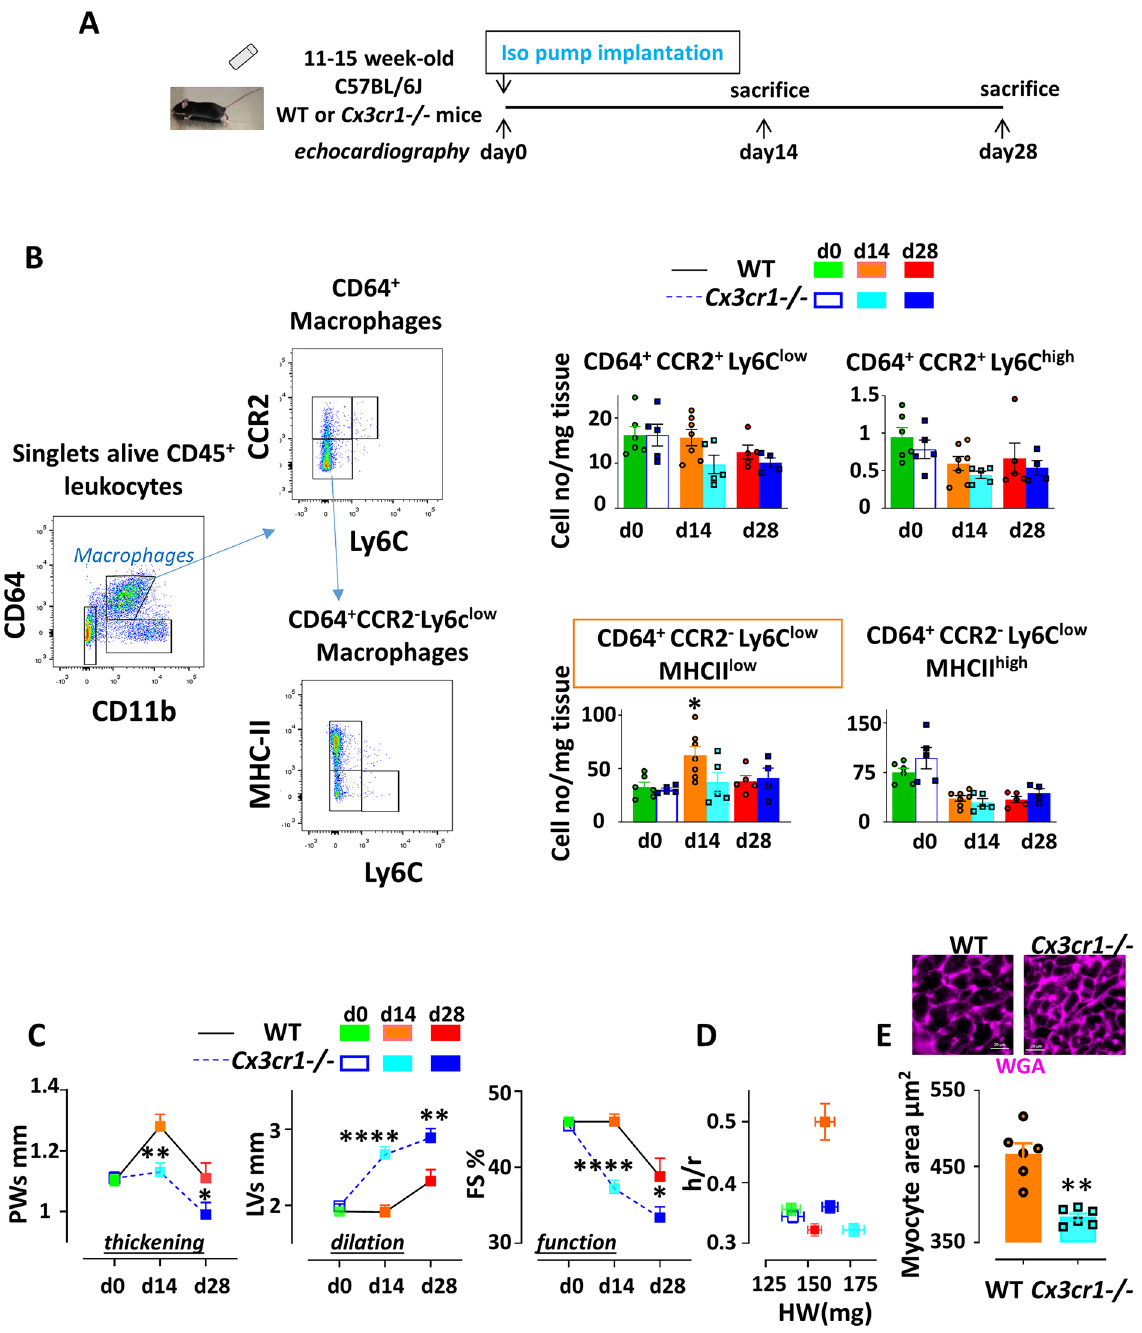
Figure 5. Cx3cr1 knockout hampers the transient selective increase in CD64 + CCR2 - Ly6C low MHCII low Mφ detected in WT mice during ECH, suppresses iso-induced concentric hypertrophy and accelerates dilation and alteration of function. ( A ) Experimental procedure ( B ) Typical flow cytometry gating strategy to identify cardiac Mφ subpopulations. Cells were isolated from collagenase digested hearts and stained with the indicated antibodies before analysis. CD45 + leukocytes were identified, doublets excluded (by FSC-W vs. SSCA). Live CD45 + cells (after PI exclusion) were gated on CD11b + CD64 + Mφ. CD11b + CD64 + Mφ were further analyzed on their pattern of expression of CCR2 vs Ly6C and CCR2 - Ly6C low cells were gated on MHCII high and MHCII low cells. Quantification of immune cells n = 4–7 cell isolation, two-way ANOVA followed by Sidak’s post-hoc tests. * p < 0.05 vs WT at the same time point. ( C ) Kinetics of echocardiography parameters in WT or Cx3cr1 -/- mice implanted with Iso pump at day 0. n = 14–38 mice, Two-way ANOVA followed by Sidak’s post-hoc tests. * p < 0.05, ** p < 0.01, *** p < 0.001, **** p < 0.0001 vs WT at the same time point. ( D ) Geometric parameter h/r versus HW n = 7–26 mice/group. ( E ) Cardiomyocyte cross-sectional area estimated in cardiac sections stained with WGA (typical image). Mean ± SEM from 6 mice/group, sacrificed at day14. Mann–Whitney U test. ** p <